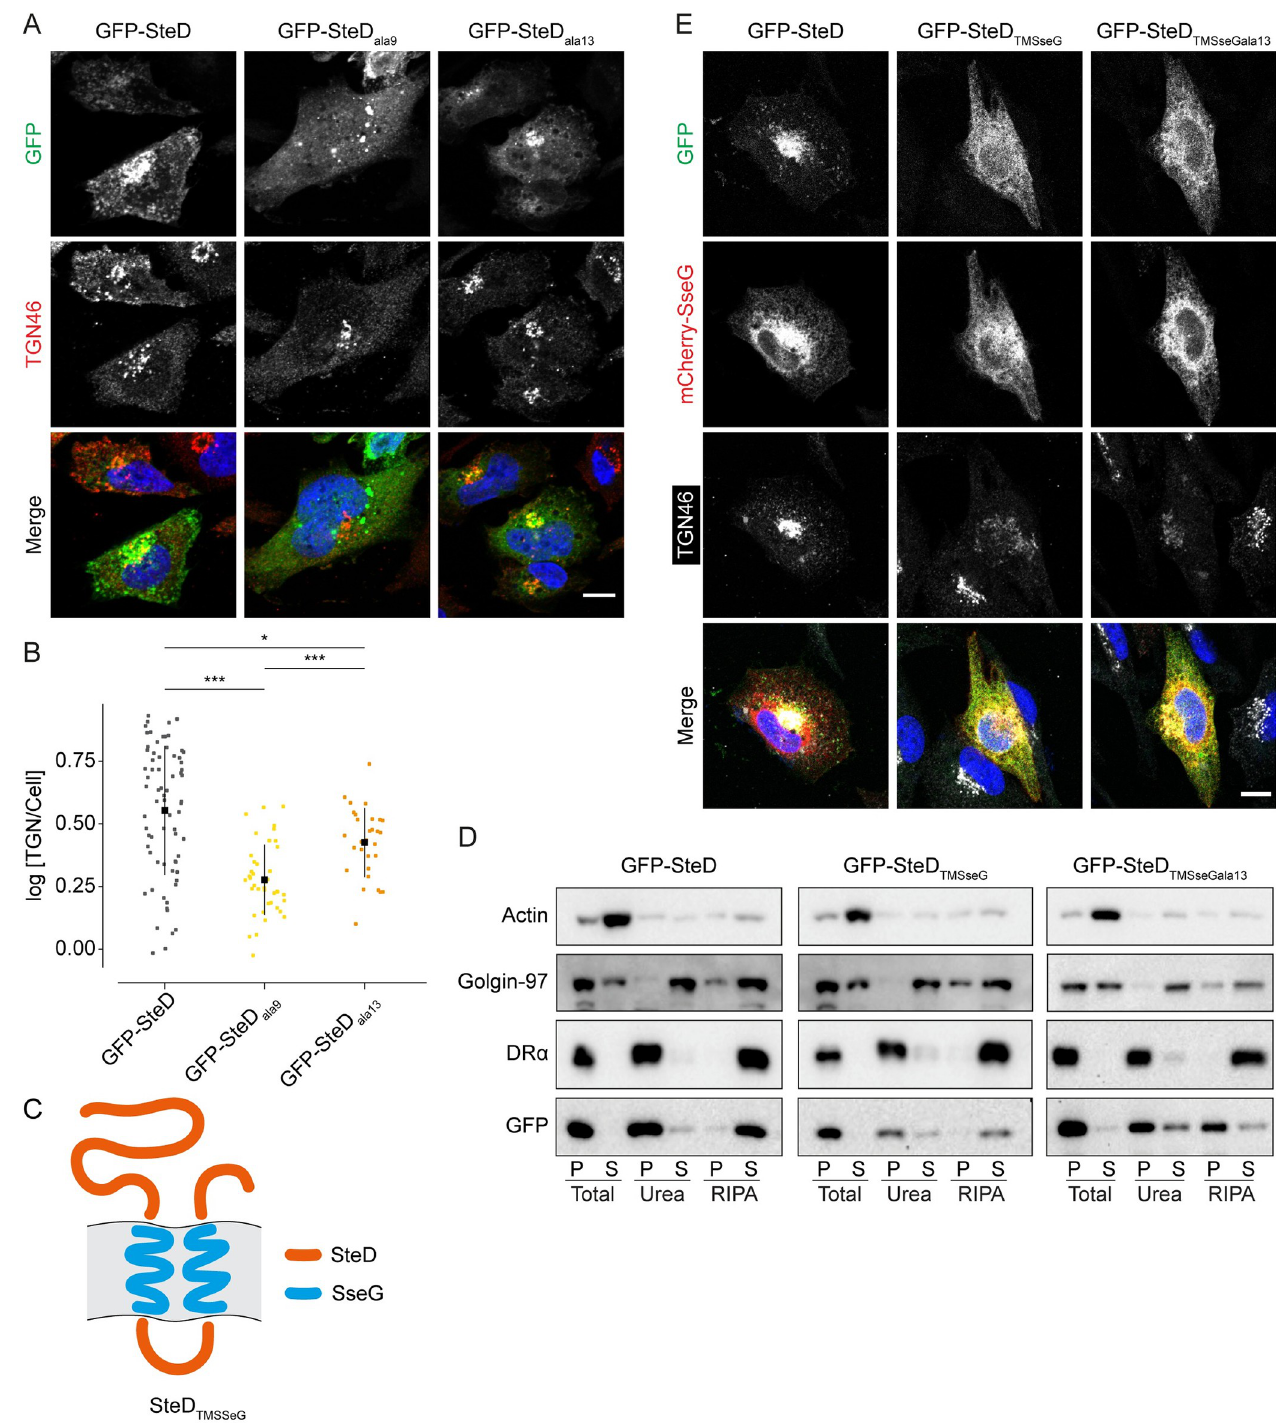
Fig 2. Recruitment of SteD to the TGN is independent from membrane integration. (A) Representative confocal immunofluorescence microscopy images of Mel JuSo cells expressing GFP-SteD (wt or mutants) after MG132 treatment. Cells were fixed and processed for immunofluorescence microscopy by labelling for the TGN (TGN46, red), and DNA (DAPI, blue). Scale bar– 10 μ m. (B) Quantification of GFP at the TGN of cells represented in Fig 2A. The fluorescence intensity of the GFP signal at the TGN was measured in relation to total cellular fluorescence. Data are representative of three independent experiments. Each dot represents the value for one cell. Mean ± SD. The log 10 fold change of the data were analysed by one-way ANOVA followed by Dunnett’s multiple comparison test, ��� p < 0.001, � p < 0.05. (C) Schematic of SteD chimera with transmembrane domains of SseG. (D) Protein immunoblots of